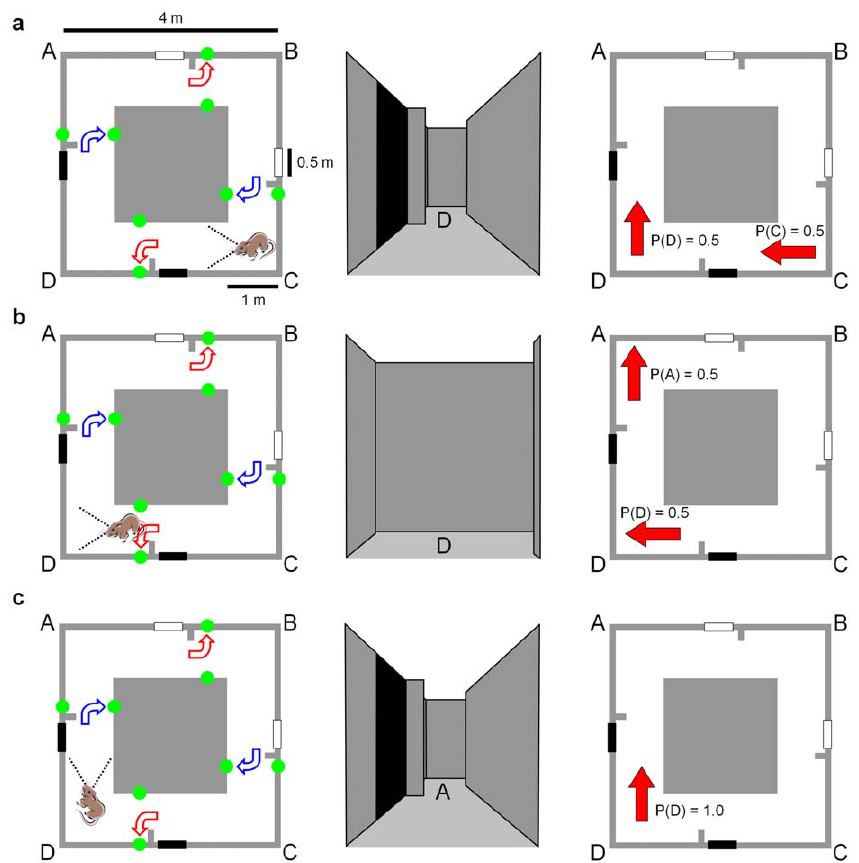
Figure 3. The perceptually ambiguous corridor arena and a schematic of the theoretically optimal navigation performance possible. A virtual rat is used to demonstrate the optimal navigation performance in the arena. The three columns show (in order from left to right) the plan view of the arena with rat location, the rat’s view of the arena at each location, and the optimal probabilistic representation of the rat’s location and orientation. Note the ‘blocker’ partitions that block the cues from sight once they have been passed (no such blockers were required for the robot due to its limited field of view). (a–b) Two equally weighted location hypotheses are maintained and updated until a second cue is sighted in (c), leading to a single correct location hypothesis. The curved arrows show the reward locations for the behavioral